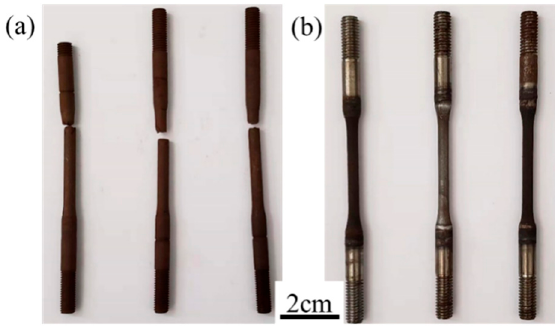
Figure 10. Casing steel sample morphology after SSC resistance test (NACE A method) ( a ) without RE ( b ) and with RE addition (0.008 wt.%).